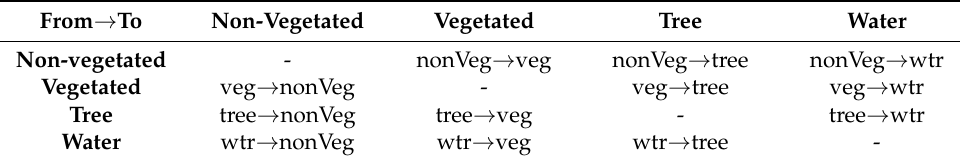
Table 2. Simplified set of land cover transitions between 2014 and 2019. From → To Non-Vegetated Vegetated Tree Water Non-vegetated - nonVeg → veg nonVeg → tree nonVeg → wtr Vegetated veg → nonVeg - veg → tree veg → wtr Tree tree → nonVeg tree → veg - tree → wtr Water wtr → nonVeg wtr → veg wtr → tree